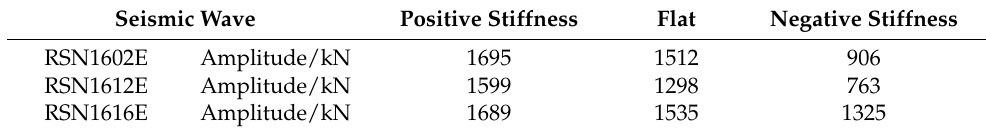
Figure 23. Time-history curve of bearing shear force under the action of near-field vibration. Table 2. Shear force amplitude and damping rate of bearing under the action of near-field